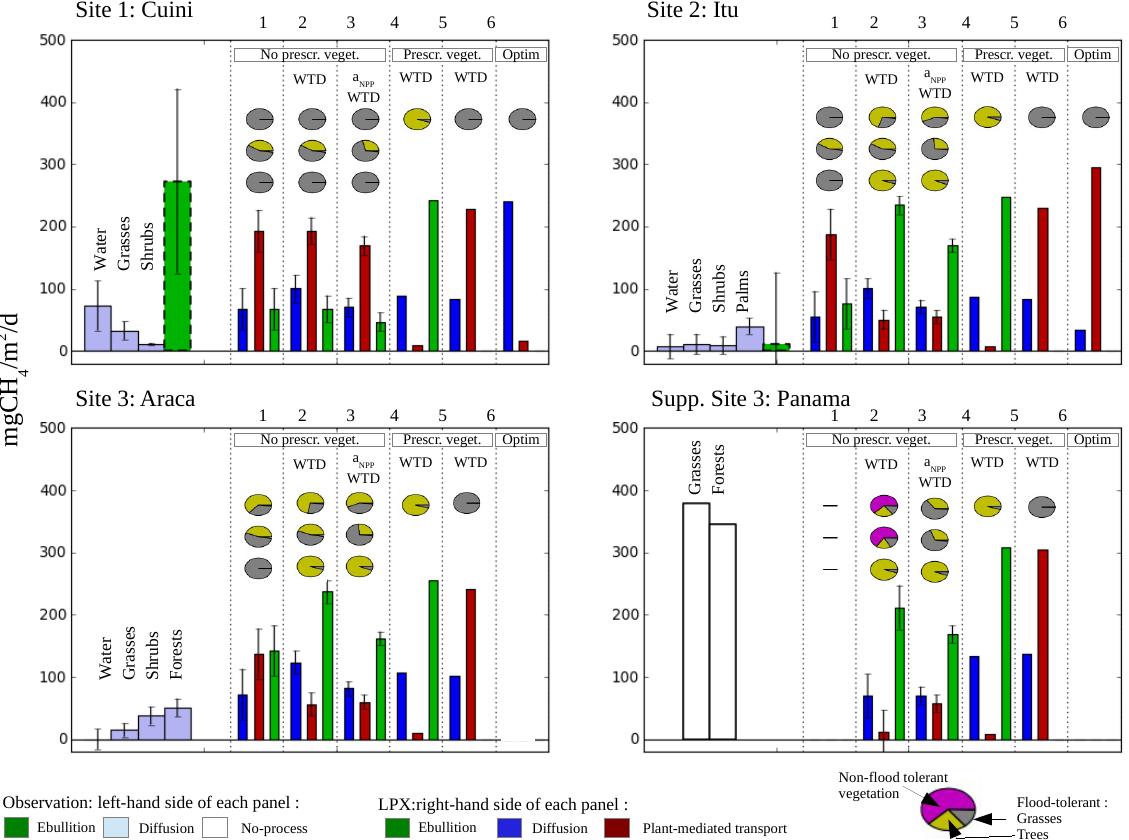
Fig. 5. Comparison of mean annual CH 4 flux densities between LPX-simulations and observations at sites 1, 2, 3 and Supp. Site 3. For these sites, information about mean annual flux density is available. The different panels correspond to the different sites. In each panel, information from observations (left-hand side) and LPX simulations results (right-hand side) are